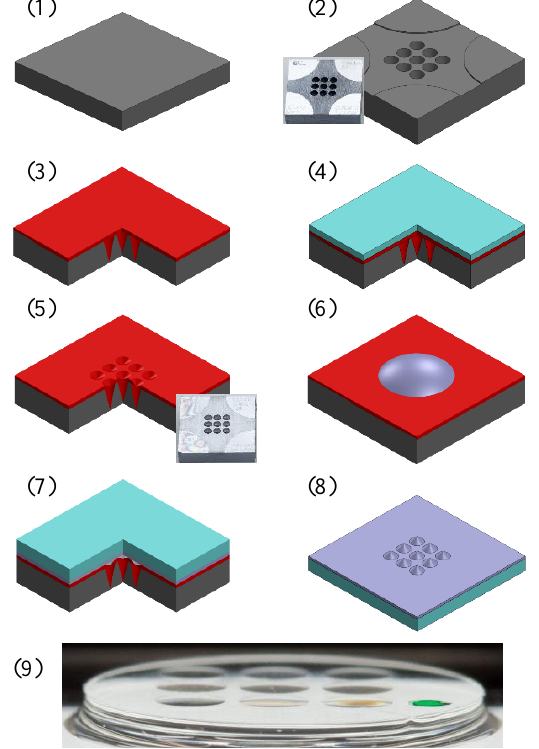
Fig. 1. Fabrication process of the transmissive aspherical optics. A funnel-shaped cavity is laser-structured into a thick silicon substrate (1 and 2). The uncured liquid PDMS is filled into the cavity (3), sealed with a glass slide (4) and heated under pressure. The still liquid polymer expands due to the elevated temperature and is pressed out of the mold. After polymerization, the device is cooled down, and the cured polymer shrinks. Small surface deformations form the lens molds (5). A UV-curable adhesive is dispensed on top of the lens molds (6), and a glass slide is pressed on (7). The device is then cured with UV-exposure, and the glass slide with the cured UV-adhesive is removed (8)